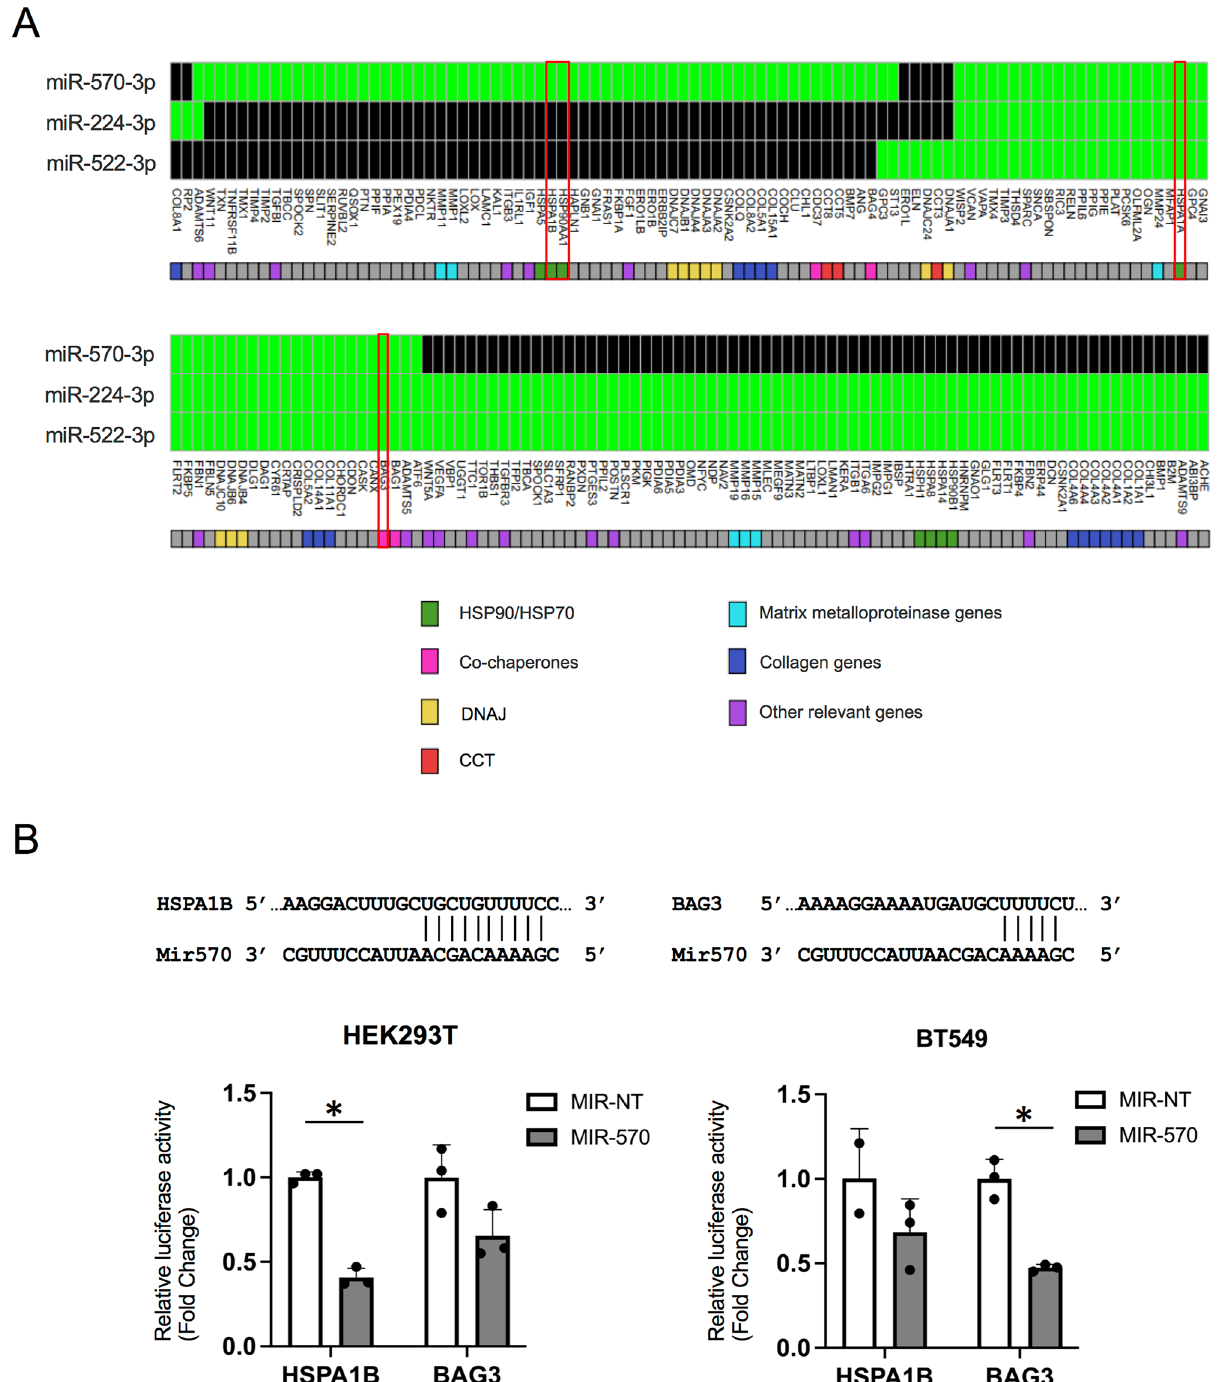
Figure 2. Determination of novel miRNAs targeting HSPs and BAG3. ( A ) Targeting genes of three candidate miRNAs in chaperome and ECM related genes. Green; the predicted positive target genes for each of the microRNA in the rows. Black; no predicted binding between the molecules studied. ( B ) Upper: Scheme of binding of miR-570 to HSPA1B and BAG3 mRNA. The figure shows sequences from the 3 ′ UTR regions of the targeting HSPA1B and BAG3 genes and the microRNA 570 predicted to bind to them. Lower: the effect of miR-570 on reporters, such as pLightSwich_3UTR_HSPA1B and pLightSwich_3UTR_BAG3. Luminescence was measured for each condition to assess binding and effectiveness of miR-570. Representative images of two individual experiments with triplicates each. (n = 3; *p < 0.05, Student’s t-test, error bars =